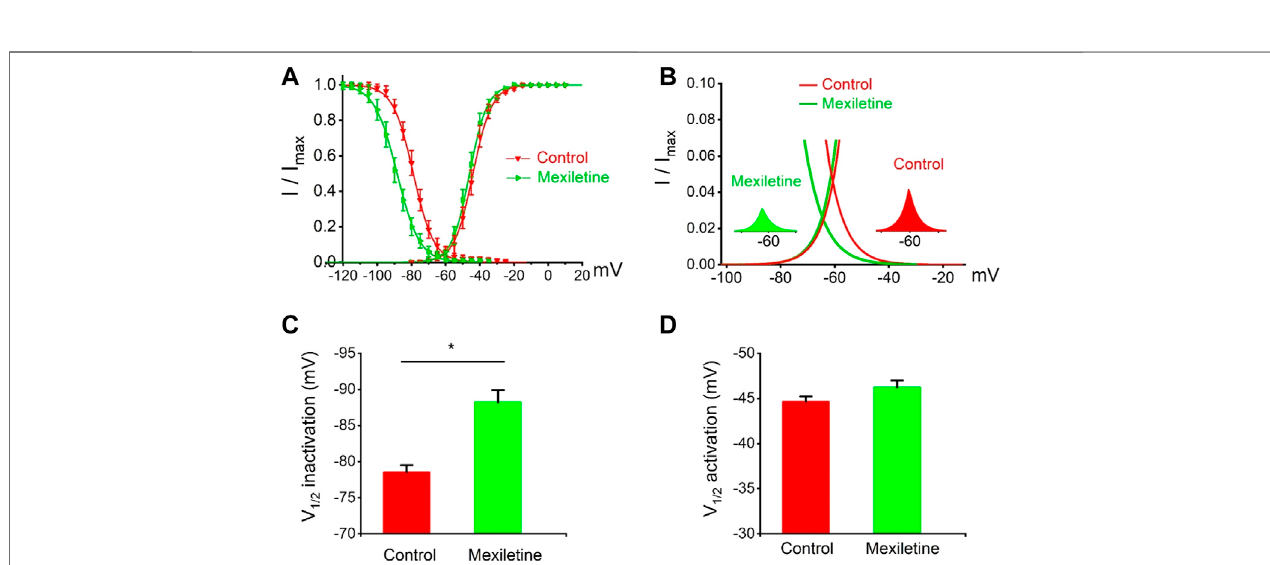
FIGURE 6 | Effects of mexiletine on voltage-dependent gating of the P1090L mutation. (A) . Steady-state inactivation and activation curves of P1090L mutation currents in the absence (Control) and presence of 200 µM mexiletine. Inactivation currents were elicited to − 20 mV following prepulses between − 120 and − 20 mV in 5 mV steps for 500 ms. Activation currents were measured from a holding potential of − 120 mV to test potentials ranging between − 110 and +20 mV in 5 mV steps. Curves are Boltzmann fi ts of the data points ( n = 8 for Control, n = 6 for Mexiletine; data are presented as the means ± SEM). (B) . The view of the overlapping area between activation and steady-state inactivation was expanded from (A) . Right inset shows P1090L mutation sodium window current without mexiletine (Control), left inset shows P1090L window current in presence of the drug (Mexiletine). (C) . Summary of V 1/2 of steady-state inactivation for control group and mexiletine group. (D) . Summary of V 1/2 of voltage-dependent activation for control and mexiletine. Data are presented as the mean ± SEM. * p < 0.05.